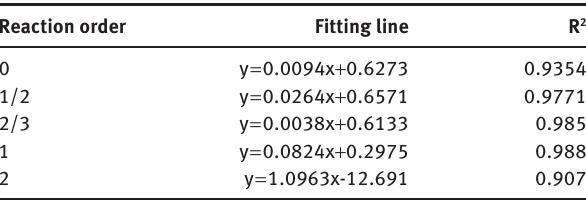
Table 5: The relationship between mechanism function and time at 650 ° C.